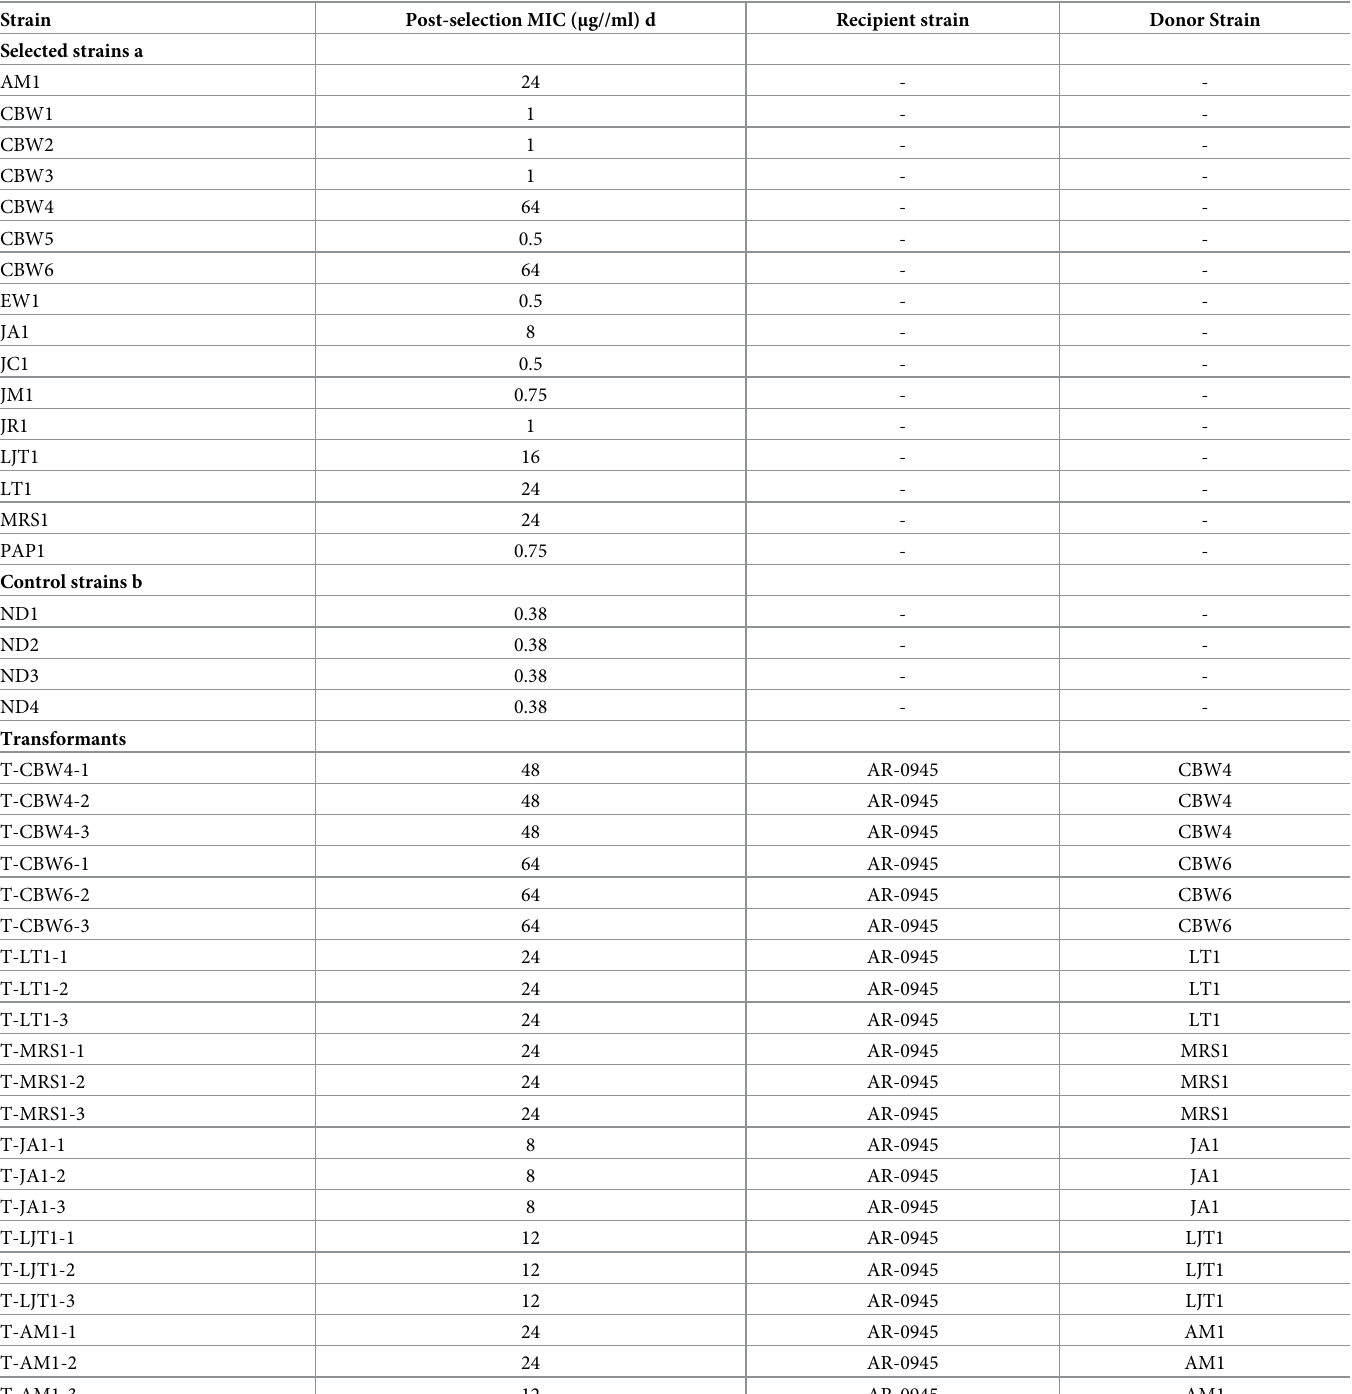
Table 1. Azithromycin MICs and derivation data for the strains used in this study.